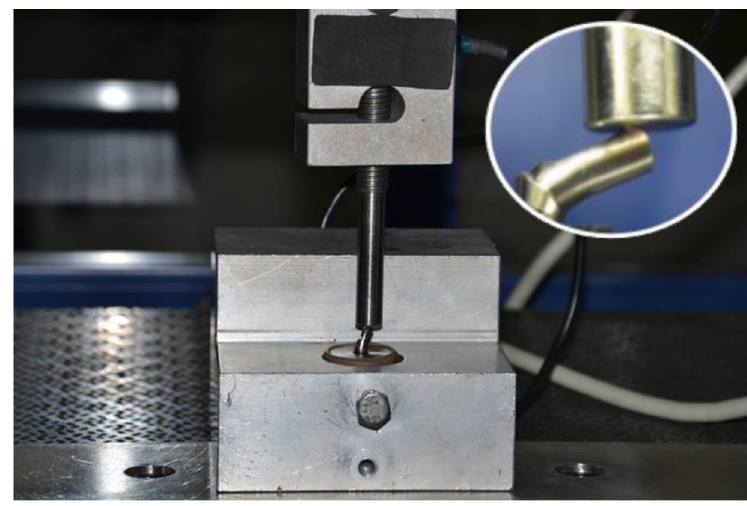
Figure 3. Compressive load test with Trd 26 load